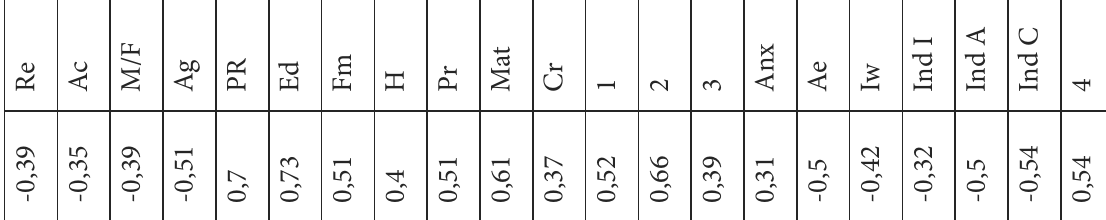
Table 2. Signi (cid:222) cant ratios of correlations between the scale “Machiavellianism” of (cid:506)(cid:526)(cid:543) - (cid:485) V methodology and diagnostic methodology scales p (cid:148) 0.01 26 Re- Responsibility; Ac-Achievement via Conformance; M/F- Masculinity-Femininity; Ag-Agreeable-